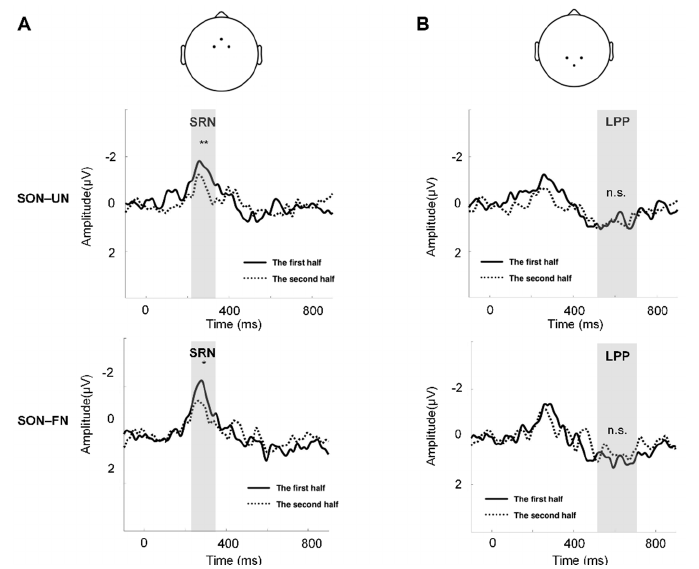
Figure 3. The comparison of SON-related effect between the first and second half of the trials. ( A ) The channels to compute the mean waveforms of SRN: Fz, FC1, and FC2 (top). The comparison of SON–UN waveforms between the two halves of trials (middle). The comparison of SON–FN wave- forms between the two halves of trials (bottom). The gray shading indicates TW1. ( B ) The channels to compute the mean waveforms of LPP: Pz, CP1, and CP2 (top). The comparison of SON–UN wave- forms between the two halves of trials (middle). The comparison of SON–FN waveforms between the two halves of trials (bottom). The gray shading indicates TW2. ** = p < 0.01, * = p < 0.05, n.s. = p > 0.05.